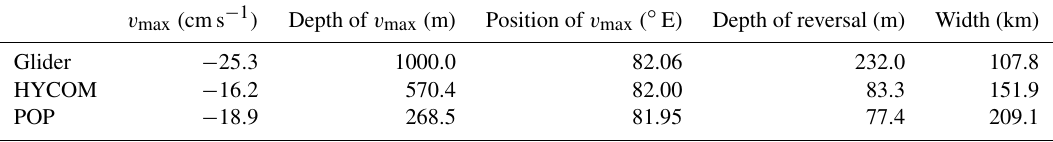
Table 1. Statistics of the undercurrent across 8 ◦ N in March from the glider geostrophic velocity as presented in Fig. 2 and mean total velocity from HYCOM and POP. Here, v max represents maximum meridional velocity; depth of reversal is defined as the depth of the zero meridional velocity at the location of the maximum velocity; width of the undercurrent is defined as the distance from the coast at the depth of maximum velocity to the location where the meridional velocity is zero.